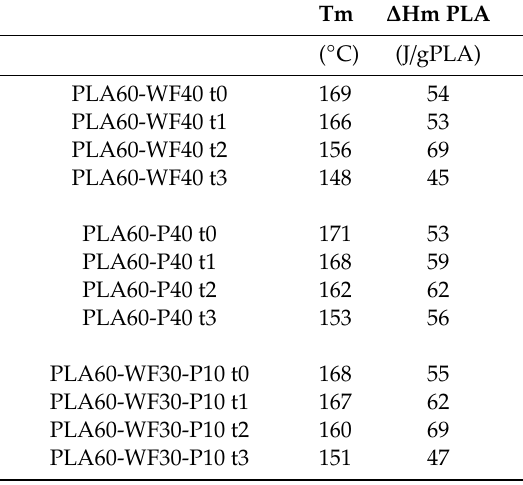
Table 5. DSC results for PLA-based composites during composting process at 58 ◦